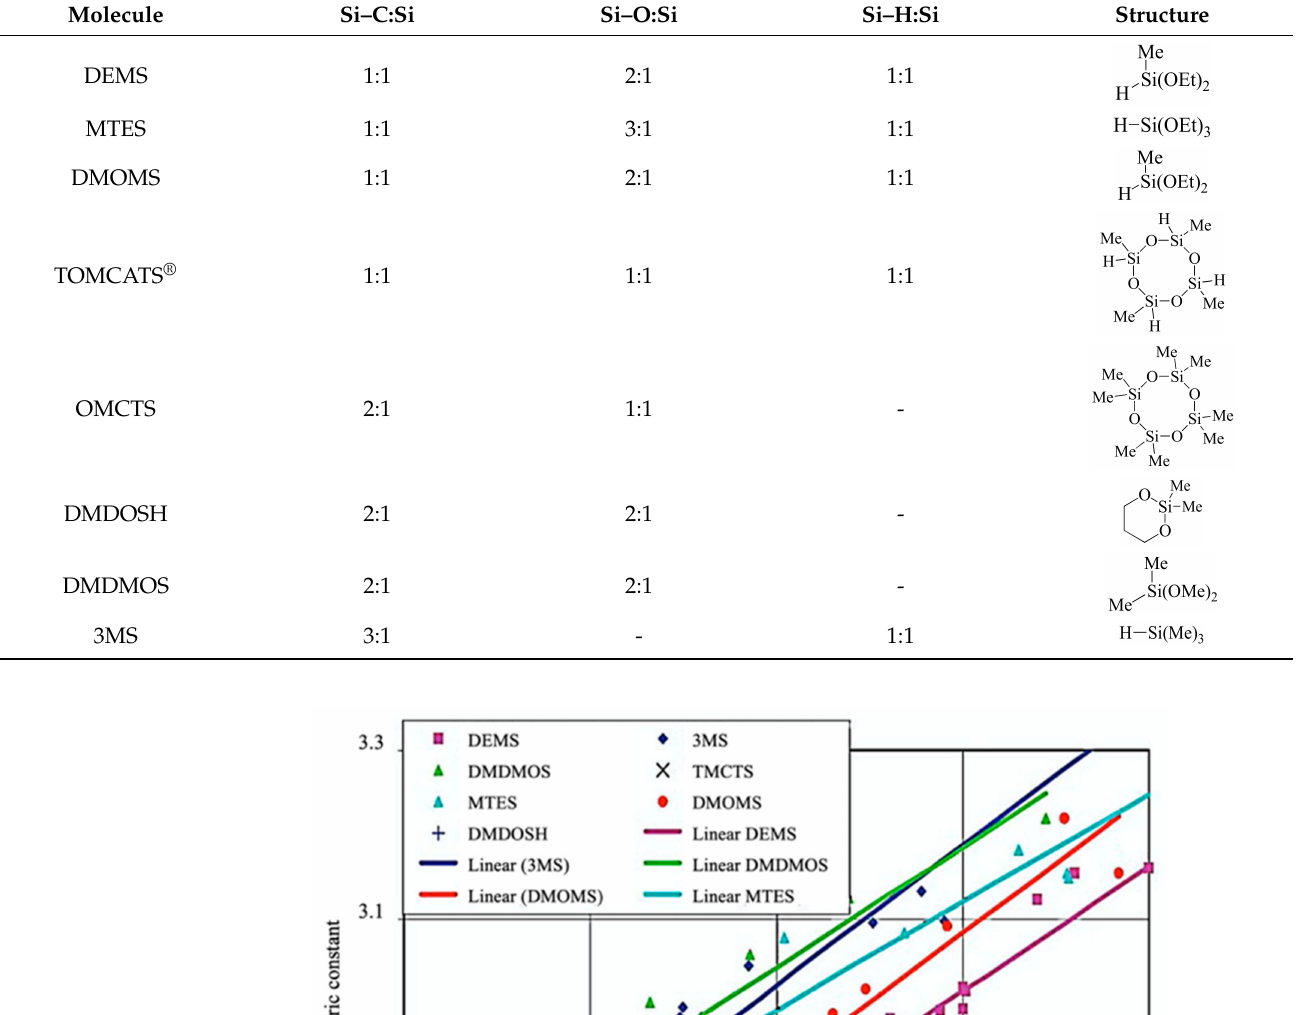
Table 2. Molar ratio of Si–C, Si–O, Si–H bonds with Si within typical organosilicon precursors.